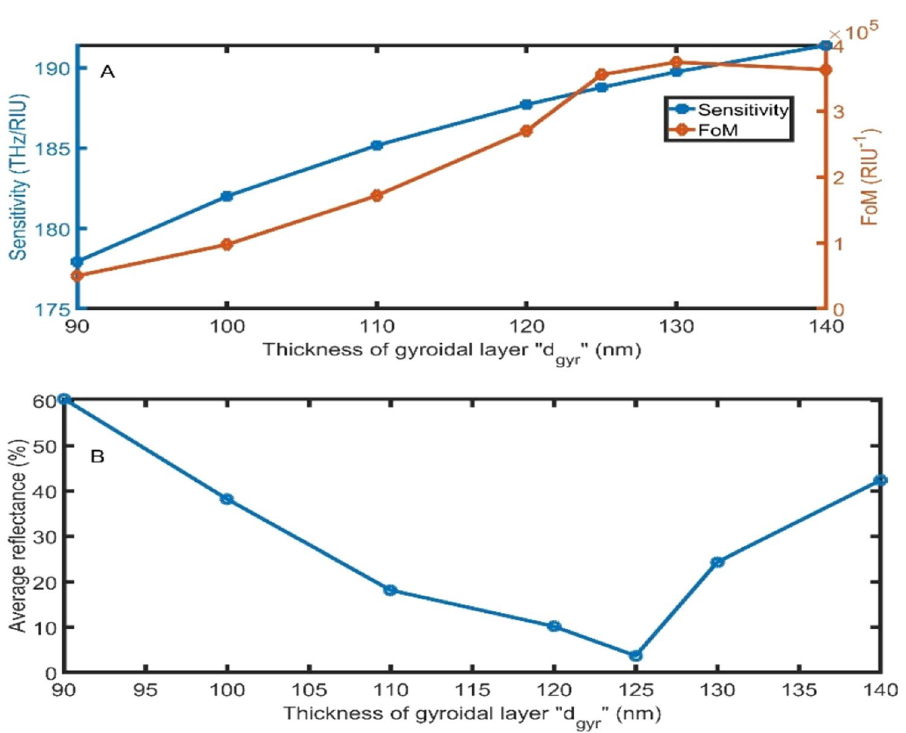
Figure 5. The (A) sensitivity and FoM, and (B) average reflectance of the proposed sensor as a function of the gyroidal graphene layer thickness by changing the sample refractive index from 1.00 to 1.01 at 80° and d sample = 16,000